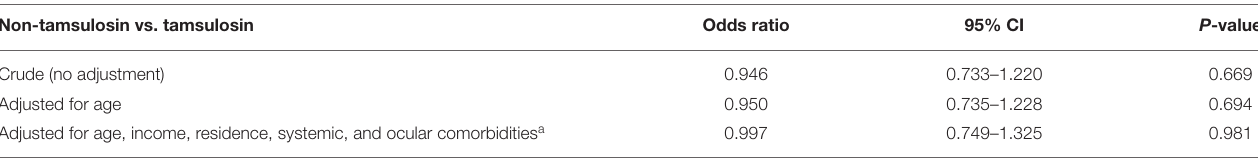
TABLE 2 | Odds Ratio of complication event of cataract surgery in the Korean elderly population with cataract surgery according to tamsulosin use. Non-tamsulosin vs. tamsulosin Odds ratio Crude (no adjustment) Adjusted for age, income, residence, systemic, and ocular comorbidities a CI, confidence interval. a Diabetes, hypertension, benign prostatic hyperplasia, vascular disease, glaucoma, myopia, eye trauma, DM with ophthalmic manifestations, severe cataract, and age-related macular